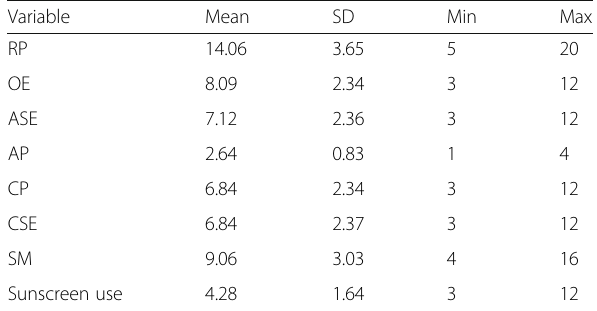
Table 2 Mean and standard deviation of the construct of